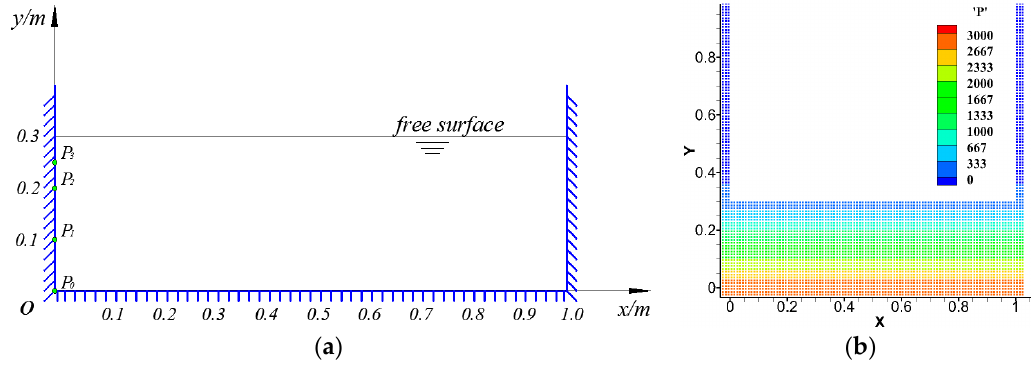
Figure 2. Initial setup of the rectangular hydrostatic test. ( a ) Computational model on the left and ( b ) initial pressure field on the right.